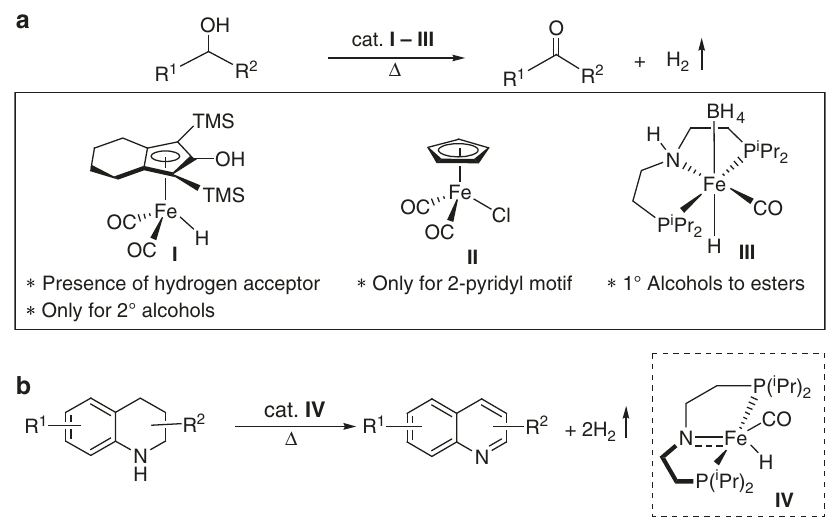
Fig. 1 Iron-catalyzed acceptorless dehydrogenation reactions. a Previous works describing homogeneous Fe complexes used for acceptorless dehydrogenation of alcohols. b Previous work involving Fe-catalyzed accceptorless dehydrogenation of N